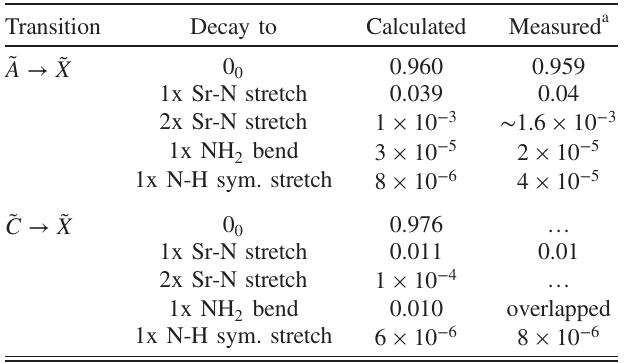
TABLE I. Comparison of measured and calculated vibrational TABLE II. Calculated multidimensional FCFs for CaNH 2 , branching ratios for SrNH 2 . Because decay to the NH 2 bending CaSH, and SrSH. The molecular geometry and vibrational ˜ frequencies used in the calculations are as reported in Refs. [52 – C → ˜ X band, we are not able to sum mode is overlapped in the experimental FCFs in this case. The molecular geometry and vibrational frequencies used in the calculations are taken from Refs. [59,61,83].